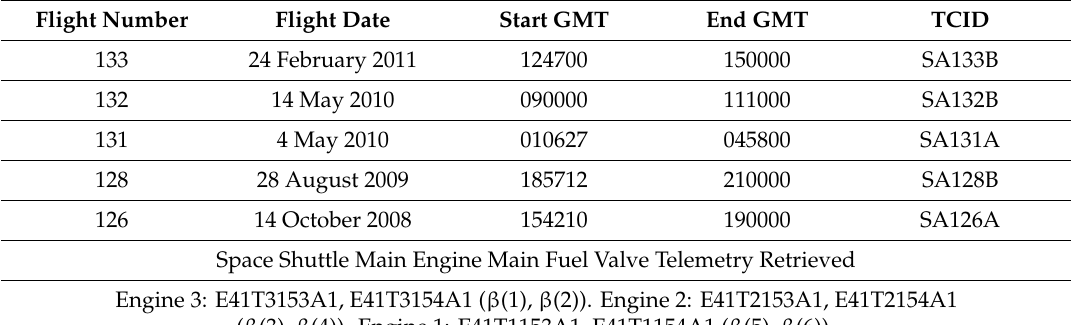
Table 1. Datasets of di ff erent shuttle flights (telemetry data from the three main engines) for